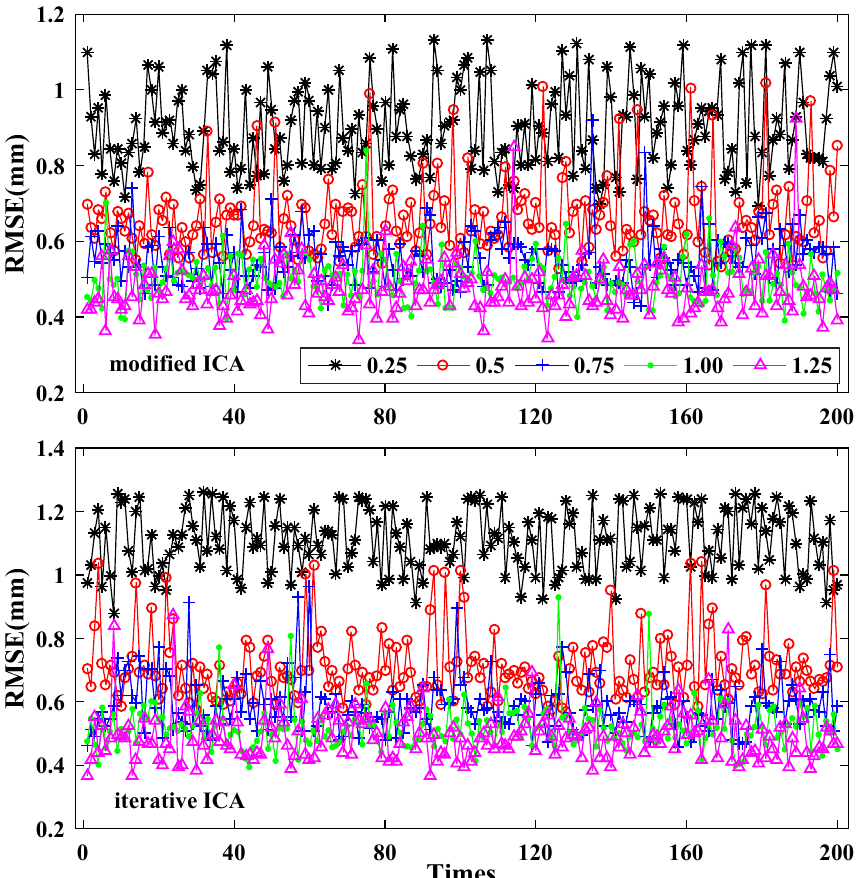
Figure 11. RMSEs of 200 experiments of modified ICA ( top ) and iterative ICA ( bottom ) in each signal-to-noise ratio (SNR) value (N coordinate component).